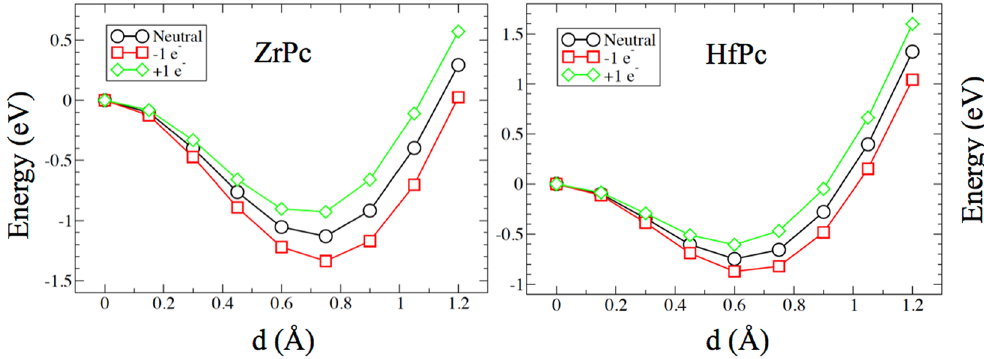
Figure 6. Energy barriers relative to the transition between the up - and down -configurations for ZrPc (right panel) and HfPc (left panel) molecules, calculated with the same method used in Fig. 2(b). d is the distance between the Zr(Hf) ion and the Pc plane. The calculations have been carried out for the neutral molecules (black lines), in the presence of an additional hole (red lines) and an additional electron (green lines) in the